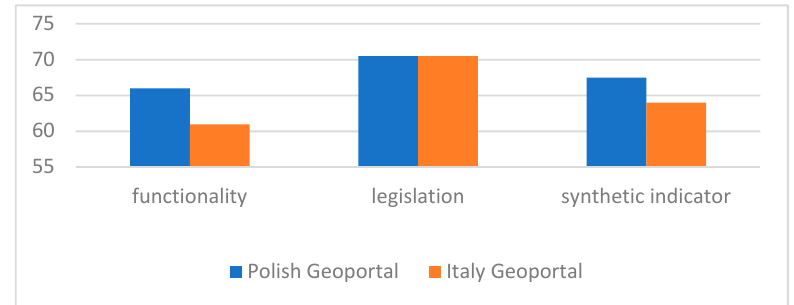
Figure 6. Results of the geoportal research.